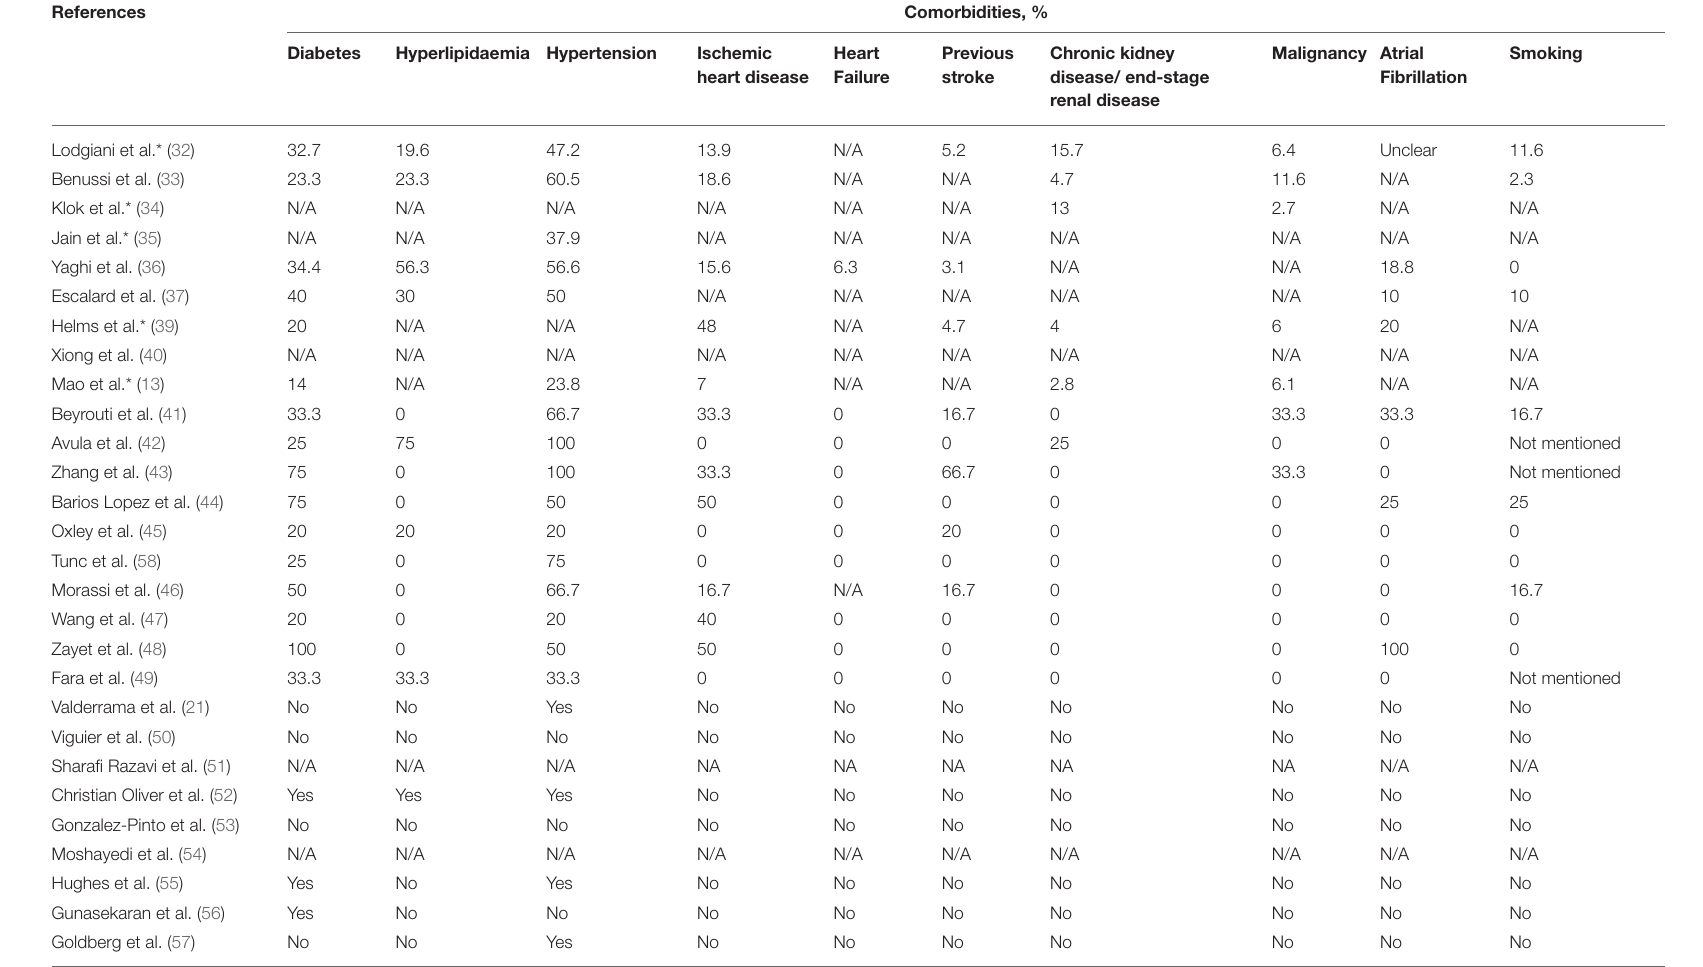
TABLE 5 | Information on comorbidities and smoking habit among patients with COVID-19 infection in the